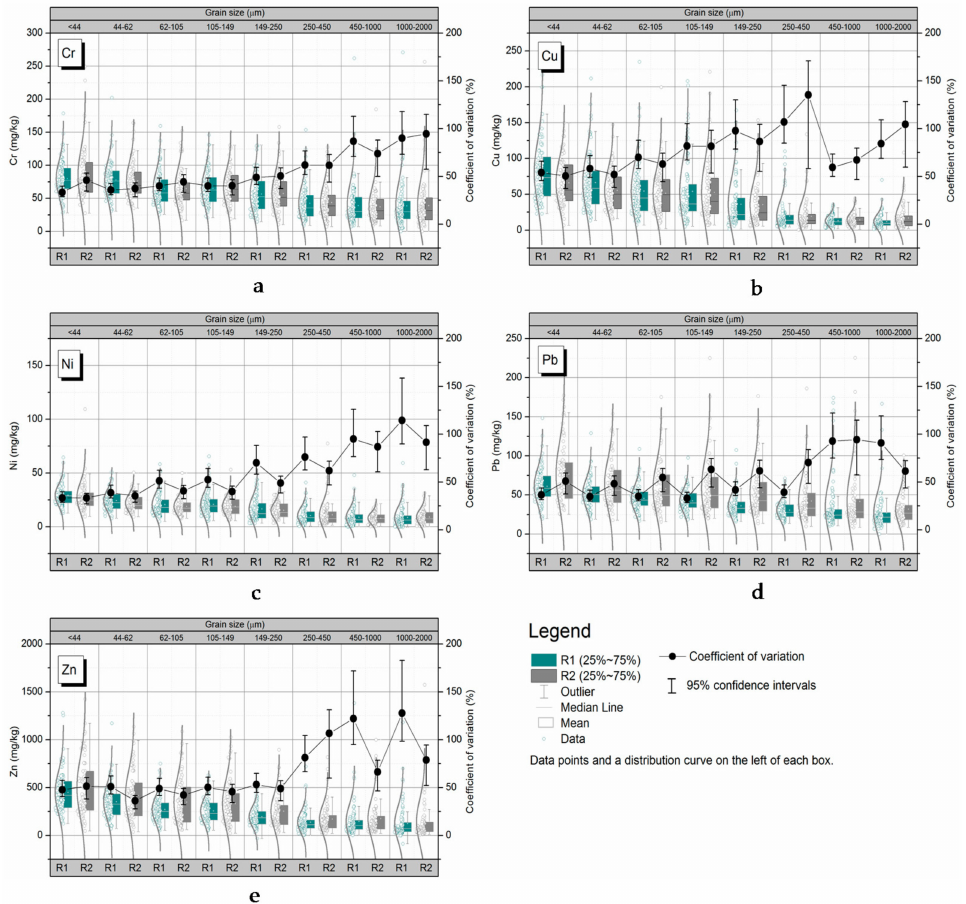
Figure 2. Grain-size heterogeneity in terms of metal concentrations present. Each Cv value shown is the mean ± the 95% confidence interval. R1 = areas in which there are main roads, R2 = residential areas; ( a ) grain-size variability in Cr concentrations; ( b ) grain-size variability in Cu concentrations; ( c ) grain-size variability in Ni concentrations; ( d ) grain-size variability in Pb concentrations; ( e ) grain-size variability in Zn